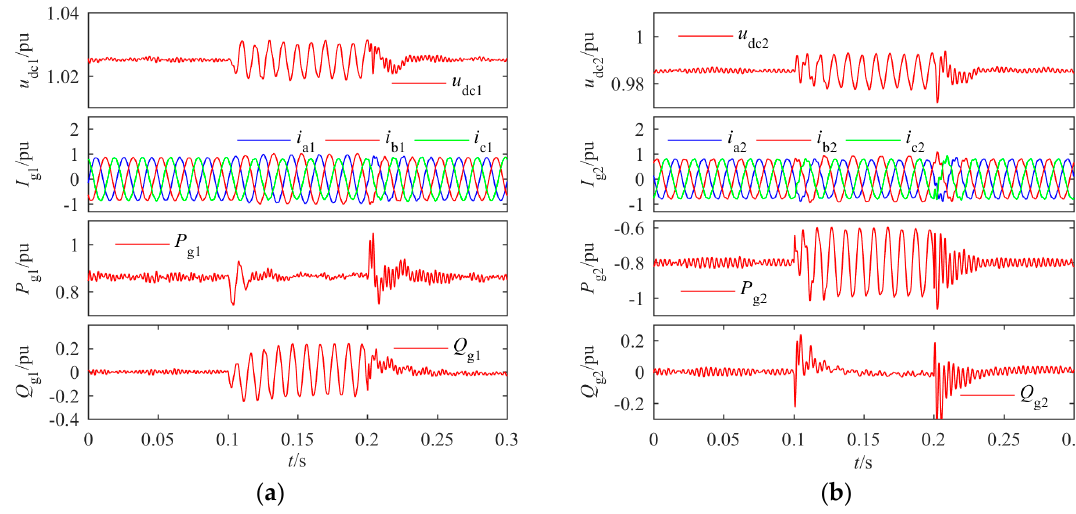
Figure 11. Responses of CS1 ( a ) and CS2 ( b ) to the SOC by the PIVR and PIR controllers with 20% reduced inductances respectively.